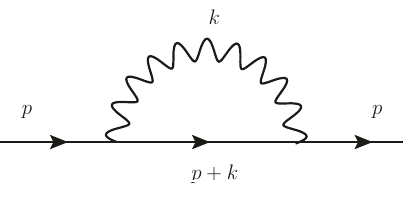
Figure 4 . Electron self-energy